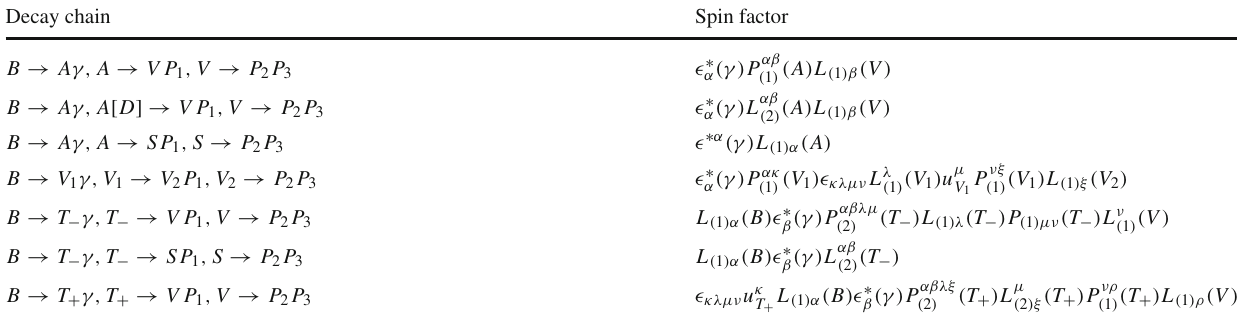
with positive and negative parity, respectively. By default, the lowest totalangularmomentum L AB accessibleineachofthetwo-bodydecays is used. The symbol [ D ] refers to decay chains where L AB is set to 2